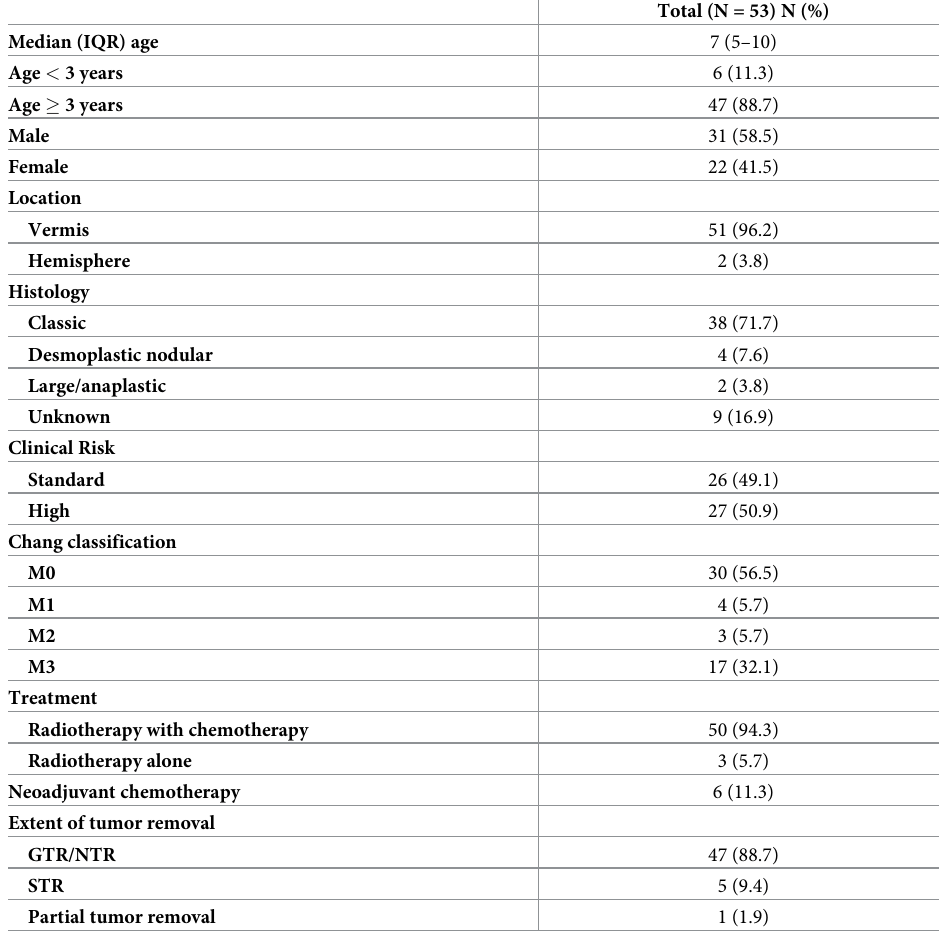
Table 1. Demographic and clinical characteristics of the 53 pediatric patients with